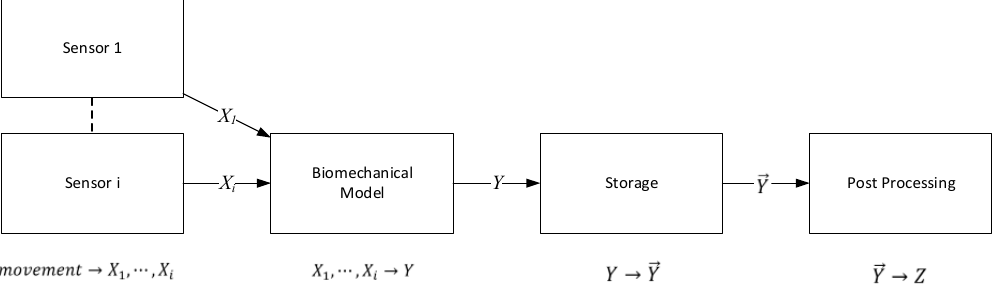
Figure 3. Description of the information flow through the ePhysio system.